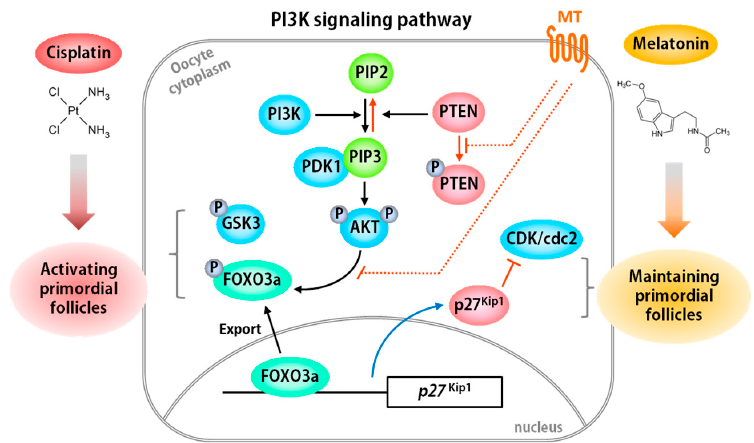
Figure 2. Schematic model for regulation of primordial follicle activation via the PI3K signaling pathway. Cisplatin induces activation of the PI3K/AKT/GSK/FOXO3a pathway via a phosphorylation cascade leading to activation of dormant primordial follicles. However, melatonin suppresses cisplatin-induced activation by inducing PTEN activity and inhibiting FOXO3a phosphorylation, thereby resulting in the expression of p27 Kip1 , CDK inhibitor, during chemotherapy. Black arrow: activation; red T bar: suppression; dotted line T bar: possible inhibition; red arrow: inactivation; blue arrow: transcription.